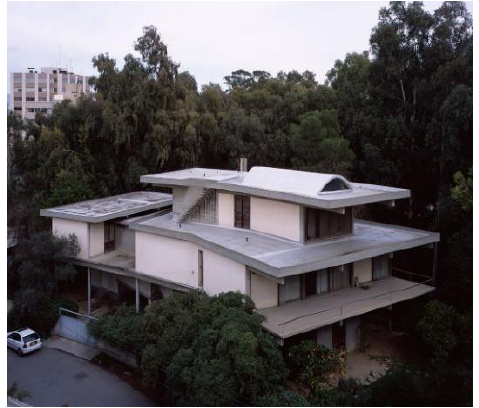
Figure 6. Neoptolemos and Maria residence.